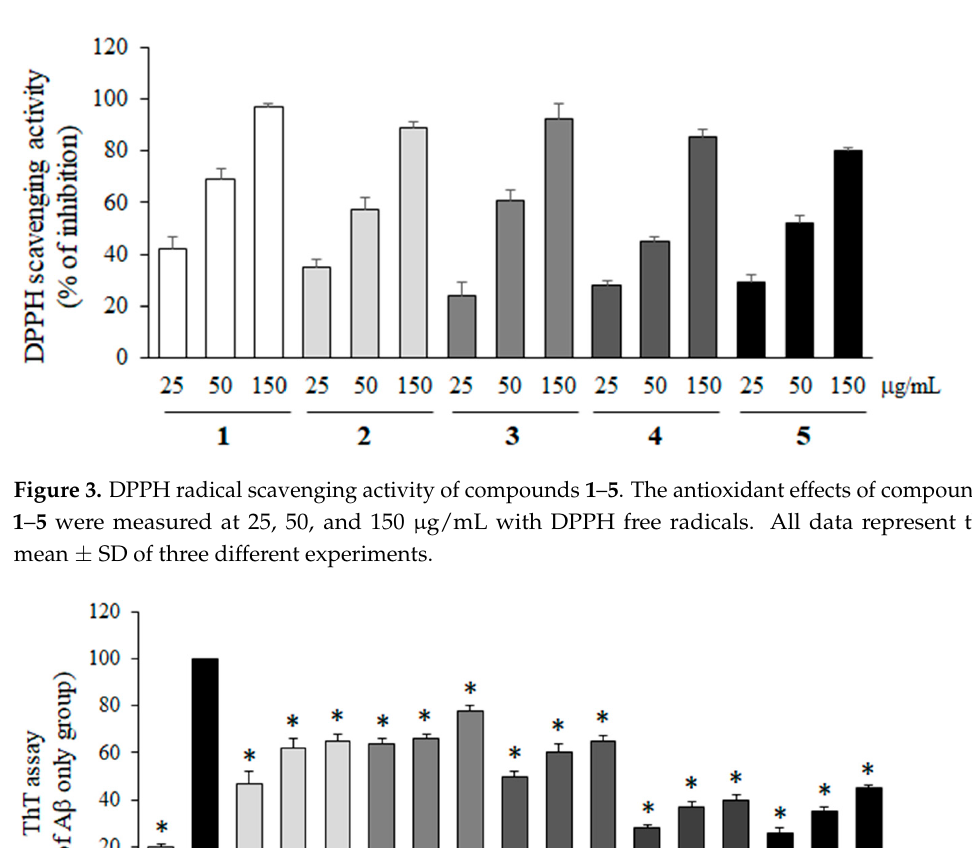
Figure 3. DPPH radical scavenging activity of compounds 1 – 5 . The antioxidant effects of com- pounds 1 – 5 were measured at 25, 50, and 150 μ g/mL with DPPH free radicals. All data represent the mean ± SD of three different experiments.